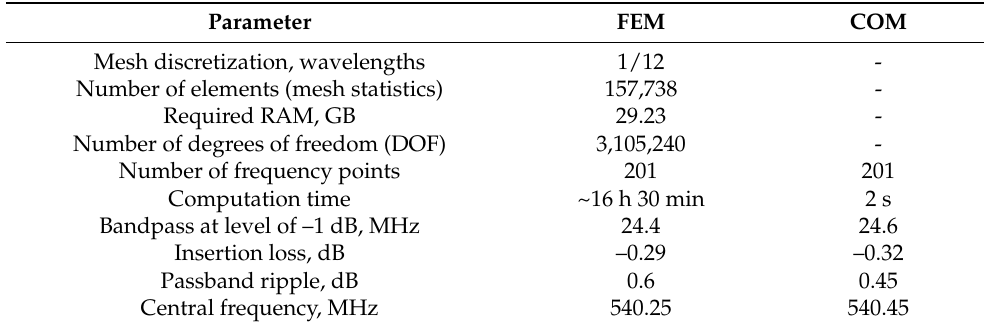
Table 1. Comparison of the result of calculating one section DMS filter based on two approaches: FEM in COMSOL and COM based